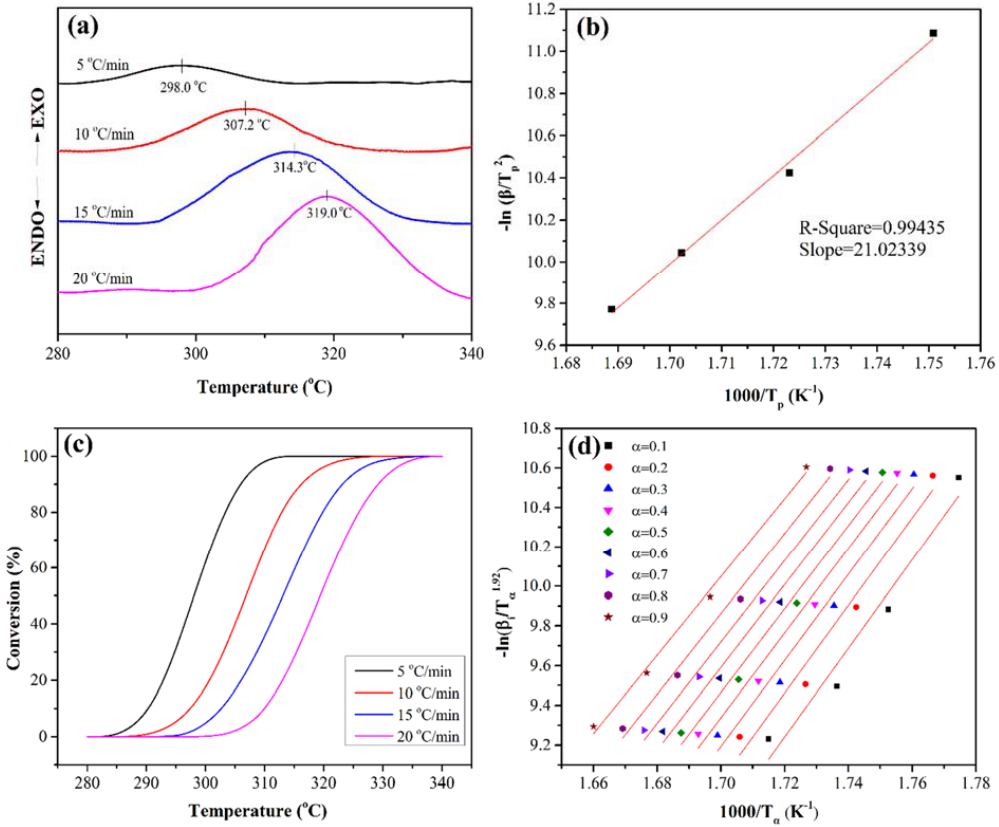
Figure 5. Crosslinking reaction behavior of the PEN ‐ Ph. Table 2. Detailed data of crosslinking activation energy at various conversions.